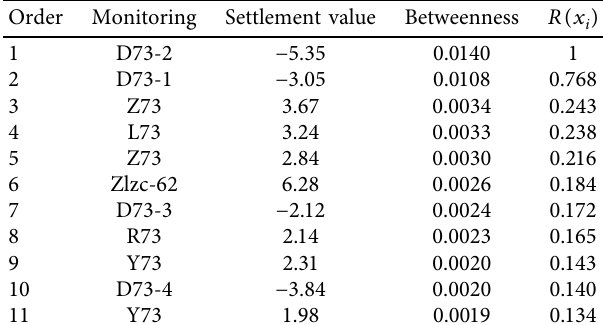
Figure 11: Risk evolution diagram of settlement system during the whole construction process of deep foundation pit adjacent to existing subway. Table 6: Betweenness centrality of each monitoring point in the 73- axis